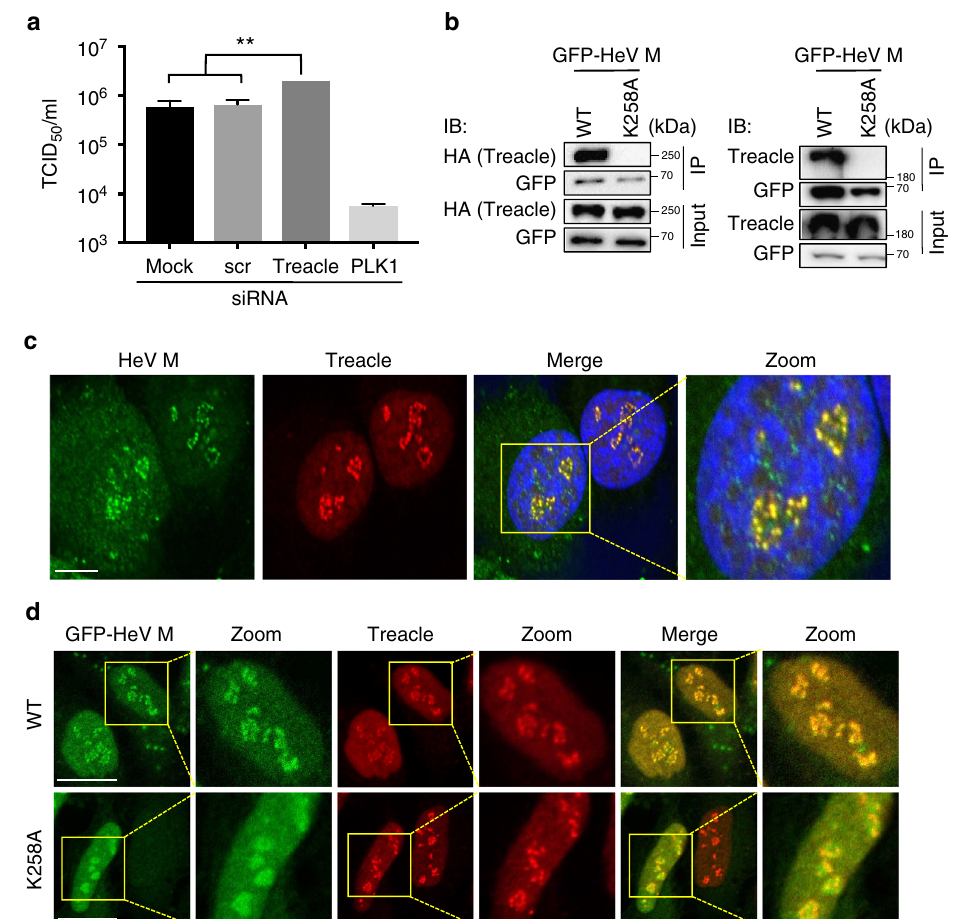
Fig. 3 Treacle impacts HeV production and interacts with wt but not K258A HeV M protein. a HeLa cells were transfected with scrambled siRNA (scr), Treacle siRNA, or mock-transfected, before infection with HeV (MOI 0.5); siRNA for polo-like kinase 1 (PLK1) is a positive control known to inhibit HeV production 17 . HeV titer was measured at 48 h p.i. (mean TCID 50 /mL, ± s.e.m., n = 3). Statistical analysis used Student ’ s t -test; **, p = 0.003. b IPs of the indicated proteins from HEK-293T cells were analyzed by immunoblotting (IB) with the indicated antibodies; results are representative of three independent experiments. c HeV-infected cells were fi xed 24 h p.i. and immunostained for HeV M protein and Treacle. Nuclei were labeled using Hoechst 33342 (blue in merged image). Images are representative of ≥ 20 fi elds of view, capturing >100 cells over two experiments. d HeLa cells transfected to express the indicated proteins were fi xed and immunostained for Treacle; images are representative of ≥ 30 fi elds of view over three experiments. Scale bars correspond to 15 μ